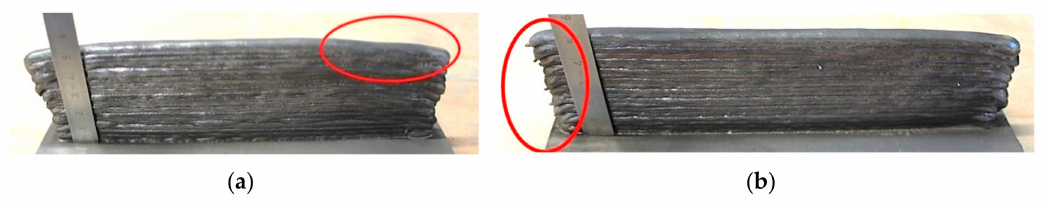
Figure 2. Influence of a front-feeding ( a ) or rear-feeding ( b ) cold wire on the specimen geometry.